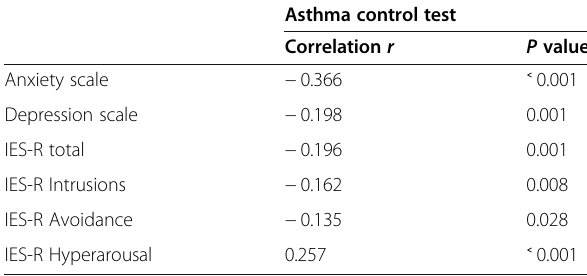
Table 5 Correlation between psychological tests and asthma control test